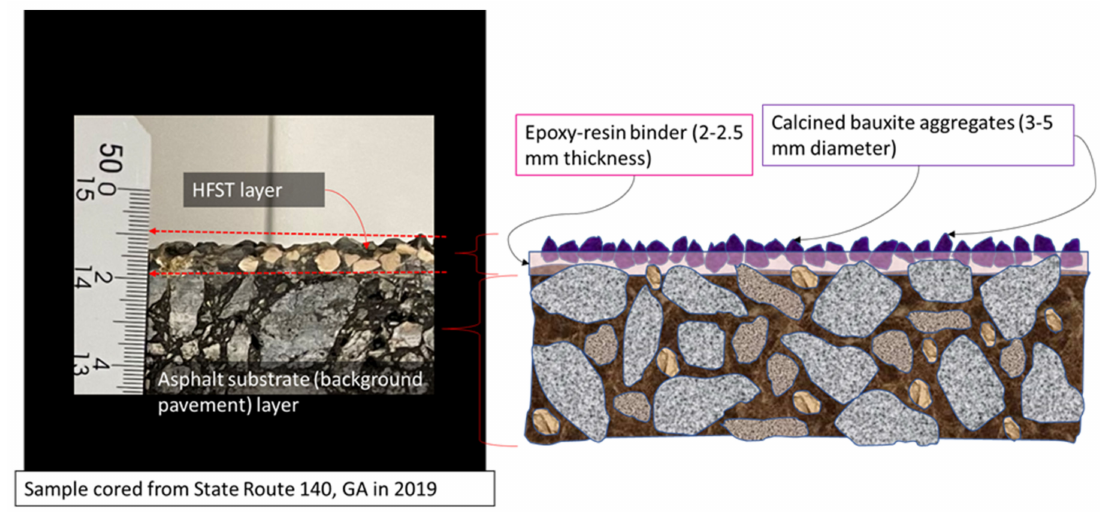
Figure 1. Cross section of HFS and illustration showing the typical dimensions of epoxy and calcined